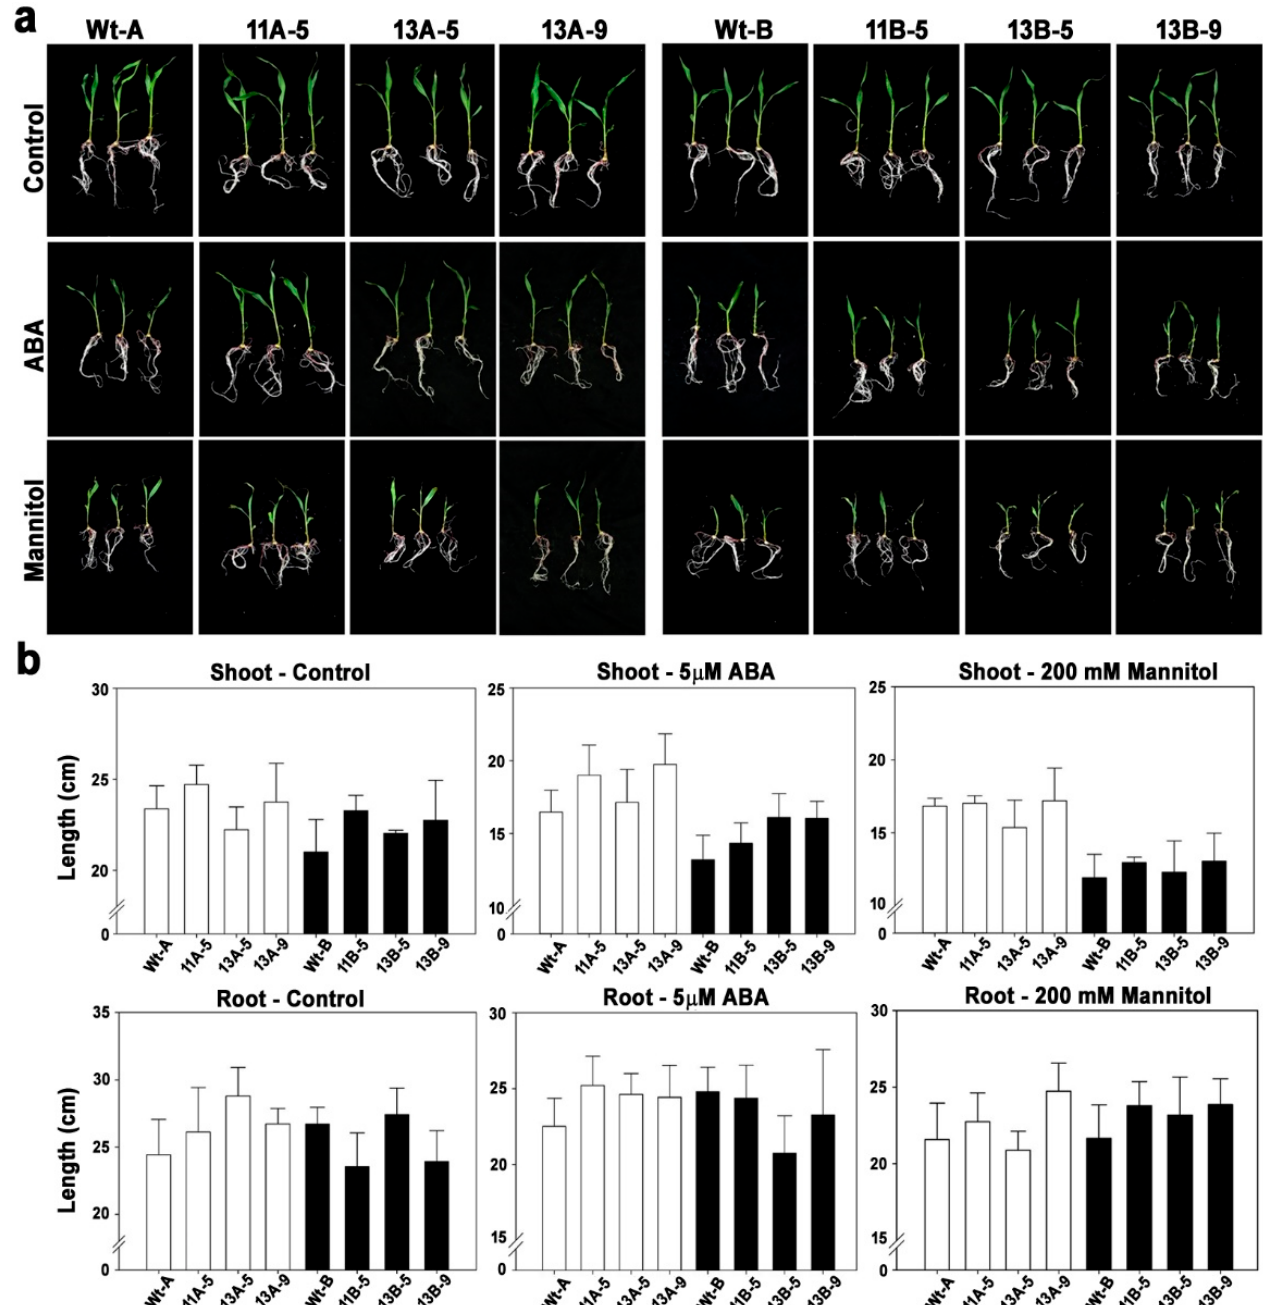
Figure 3. Post-germination assay of OsPYL/RCAR7 -OX transgenic maize lines under abscisic acid (ABA) treatment and osmotic stress conditions. ( a ) OsPYL/RCAR7 -OX transgenic and wild-type seedlings grown on half-strength MS medium containing 5 µM ABA or 200 mM mannitol. ( b ) Root and shoot lengths of seedlings from the postgermination assay. Bars represent the means ± SE of three replicates. Wt, untransformed wild-type seedlings; and 11A-5 to 13B-12, selected transgenic lines.